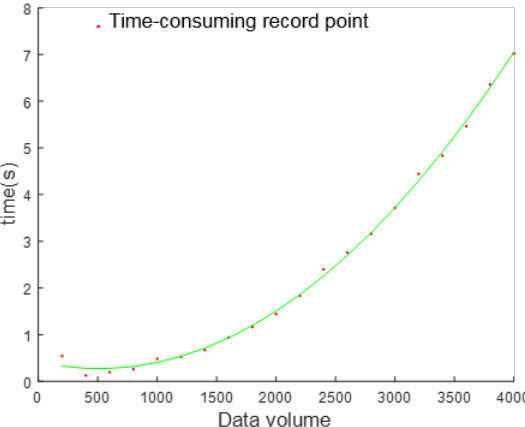
Figure 5. Time consumption of LSSVM algorithm changes with data volume.